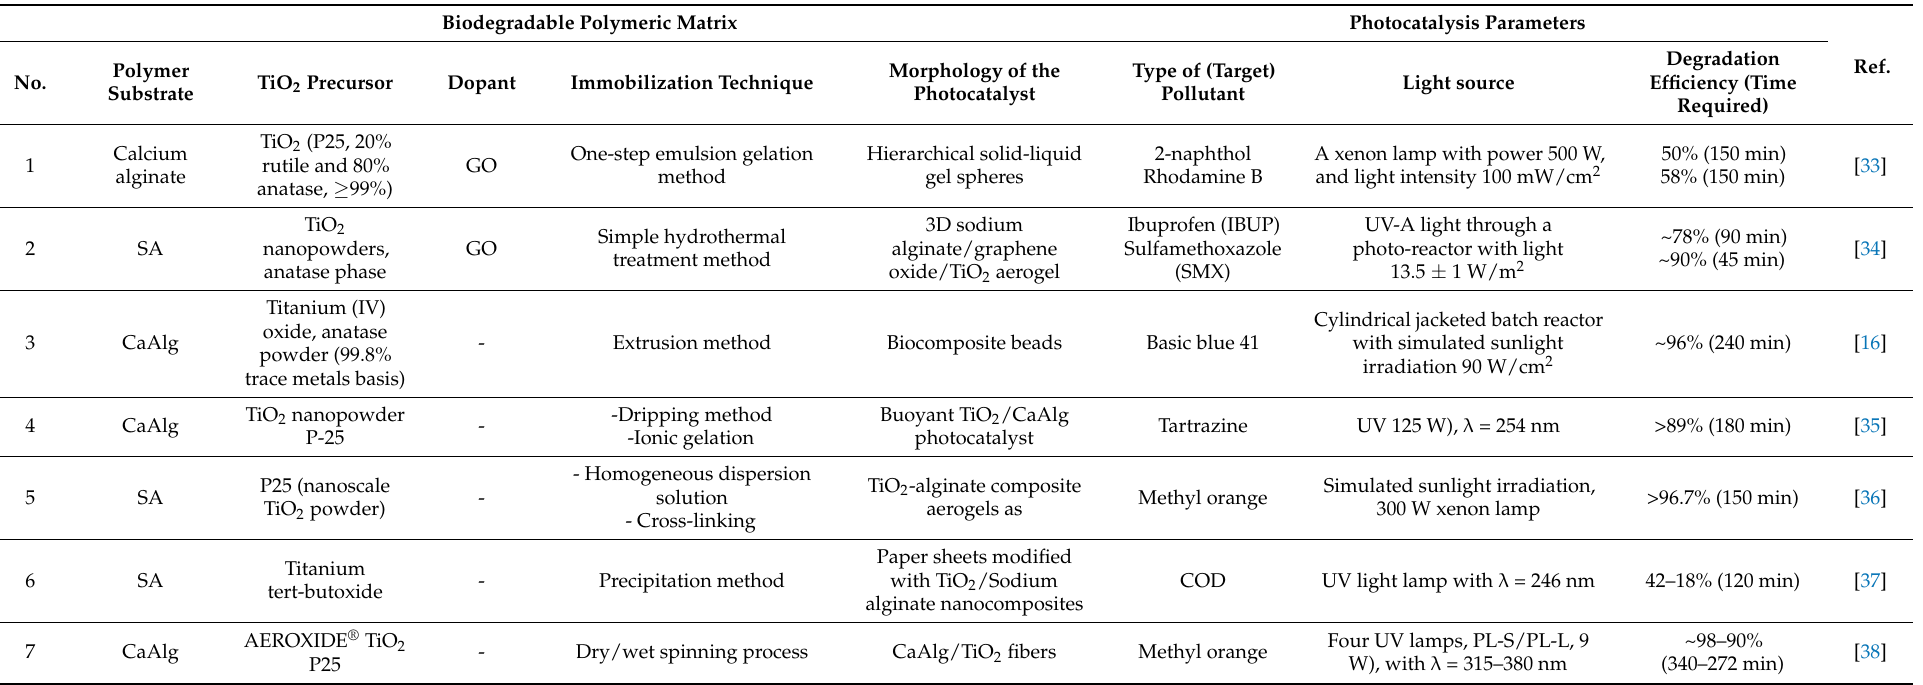
Table 3. Summary of the alginate-supported TiO 2 photocatalysts enclosed in the presented literature. Biodegradable Polymeric Matrix Photocatalysis Parameters